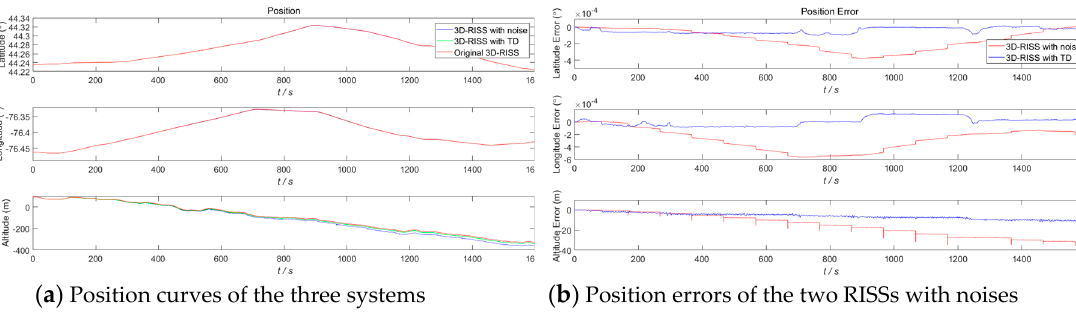
Figure 11. RISS position and position errors with a noisy odometer velocity filtered by TD.